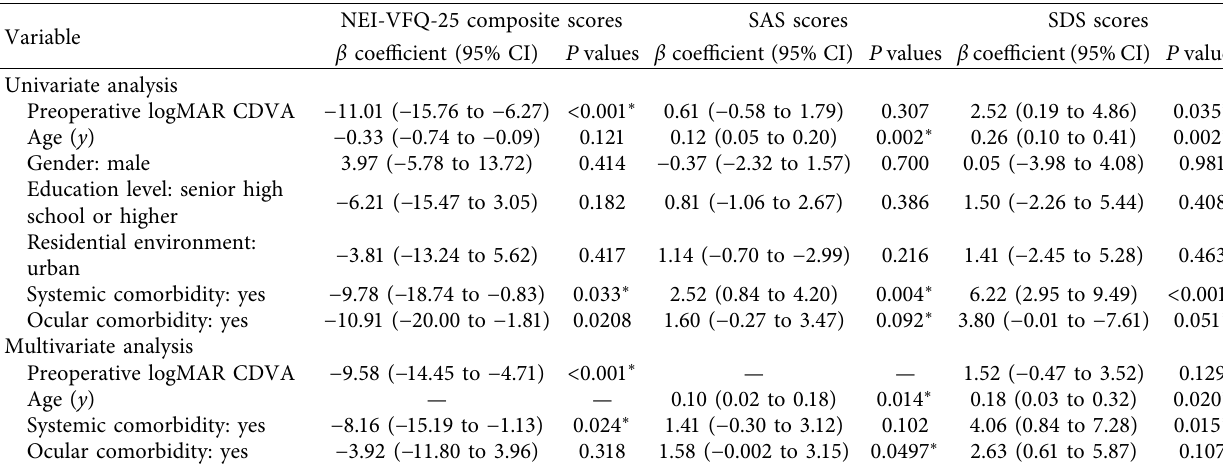
Figure 2: (a) Preoperative logMAR CDVA versus postoperative logMAR CDVA for the monocular group. (b) Preoperative logMAR CDVA versus changes in the logMAR CDVA for the monocular group. Table 3: Linear regression analysis of factors associated with postoperative NEI-VFQ-25 composite scores, SAS scores, and SDS scores for the monocular